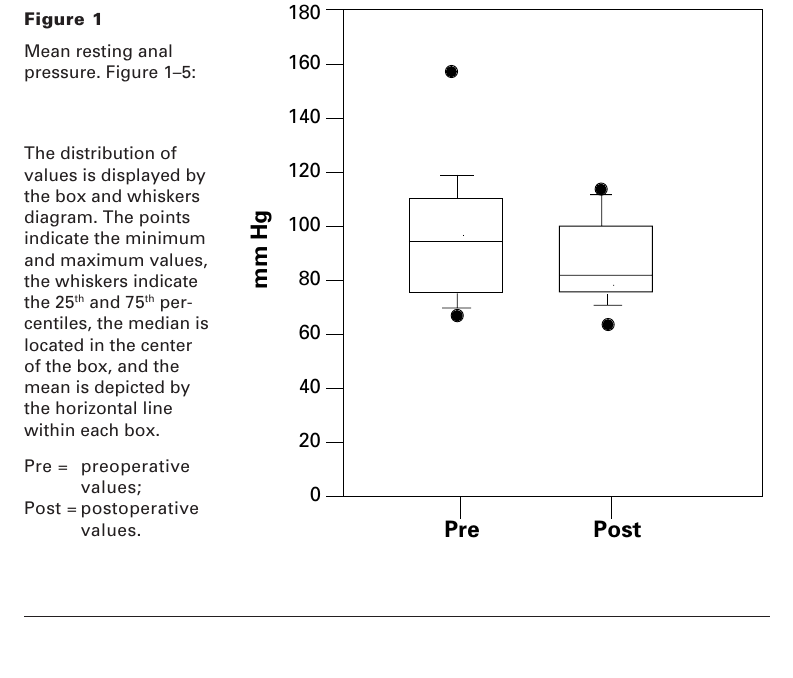
Mean maximal squeeze anal pressure.